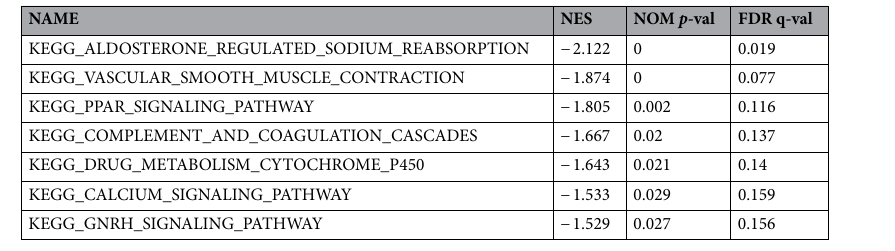
Table 6. Gene sets over-represented in low MND1 expression